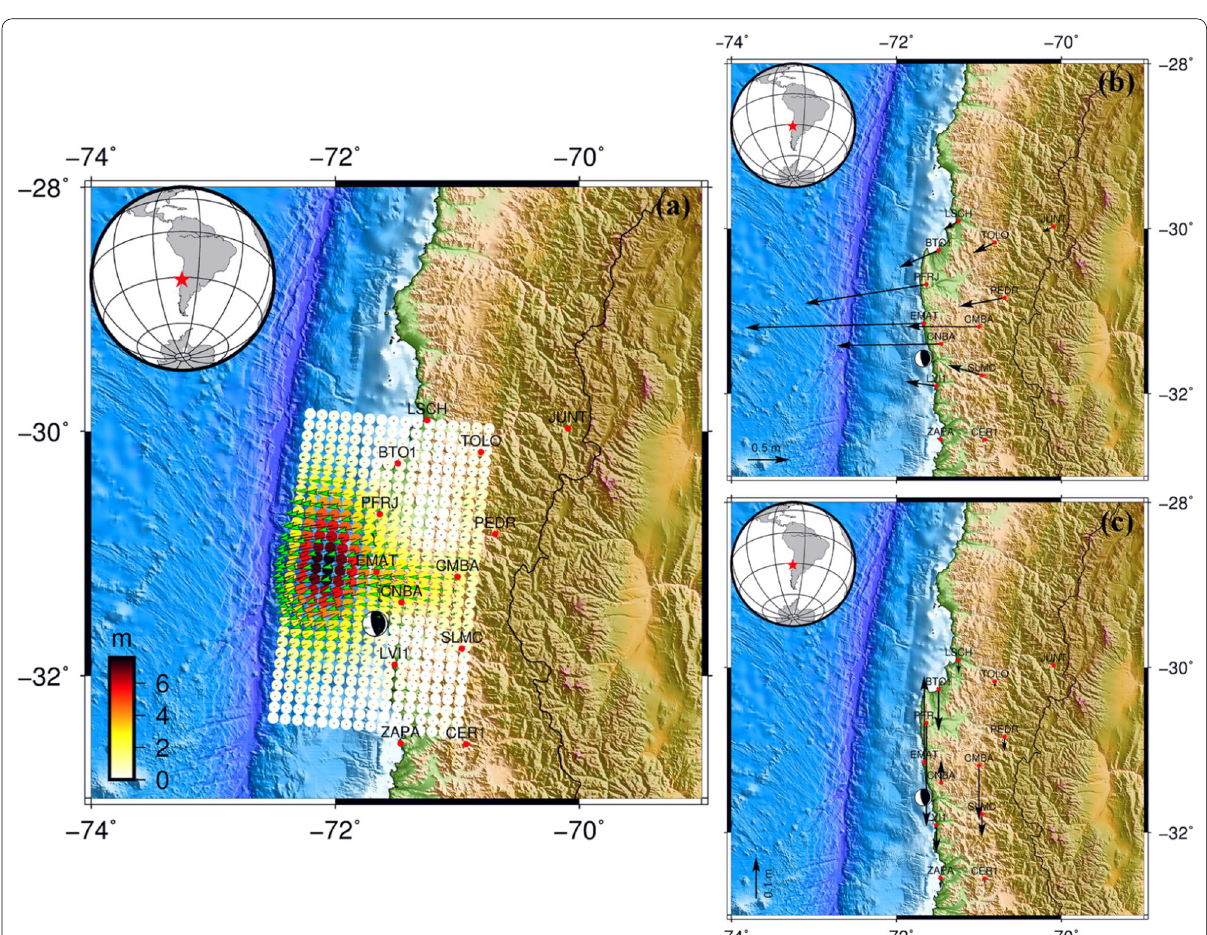
Fig. 7 Coseismic slip distribution ( a ) and coseismic deformations in the horizontal ( b ) and vertical ( c )